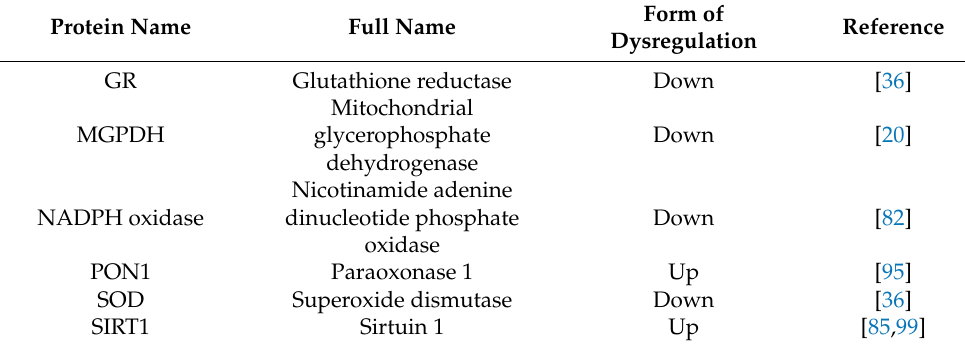
Table 2. Metformin’s antioxidant